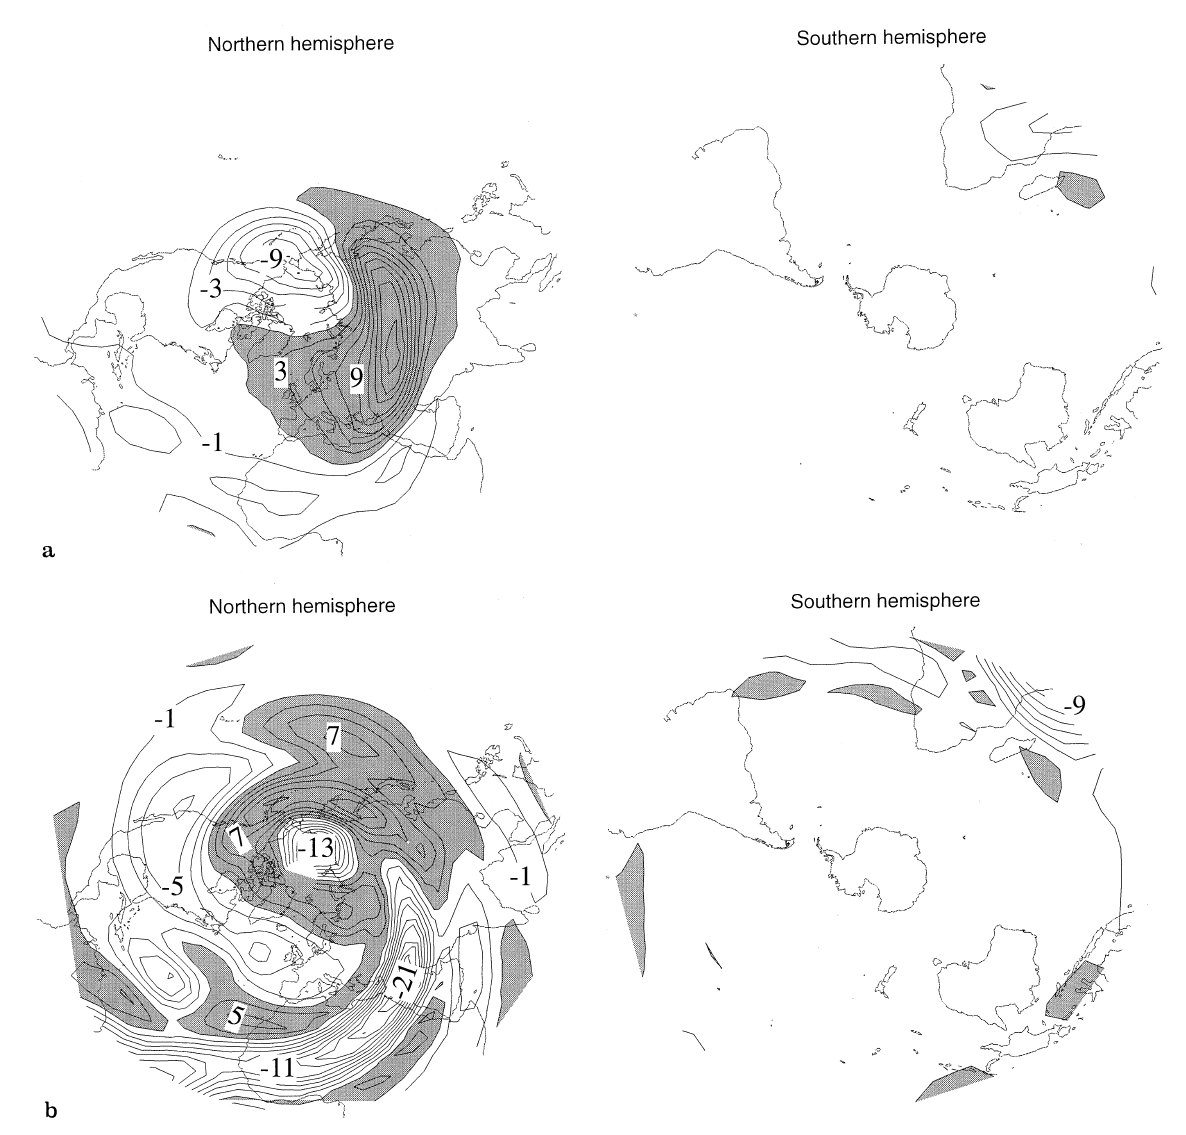
Fig. 5. As Fig. 4 but showing the polar stereographic cross sections at (cid:126) 30